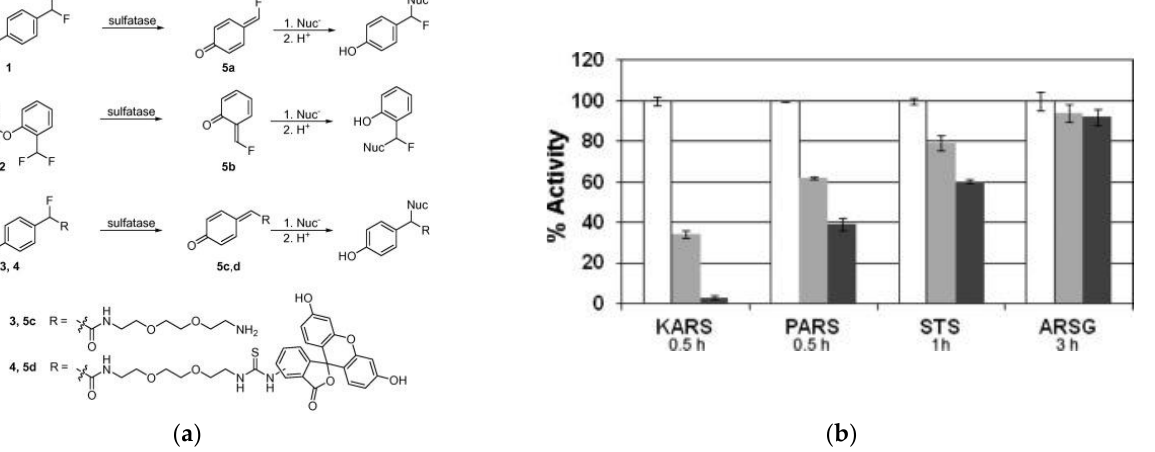
Figure 17. ( a ) Activation of probes 1 – 4 by sulfatase activity. ( b ) Inhibition of the four sulfatases (white: without inhibitor, grey: 1 mM inhibitor, black: 3 mM inhibitor). Reproduced with permission from [72], copyright 2012 Elsevier .